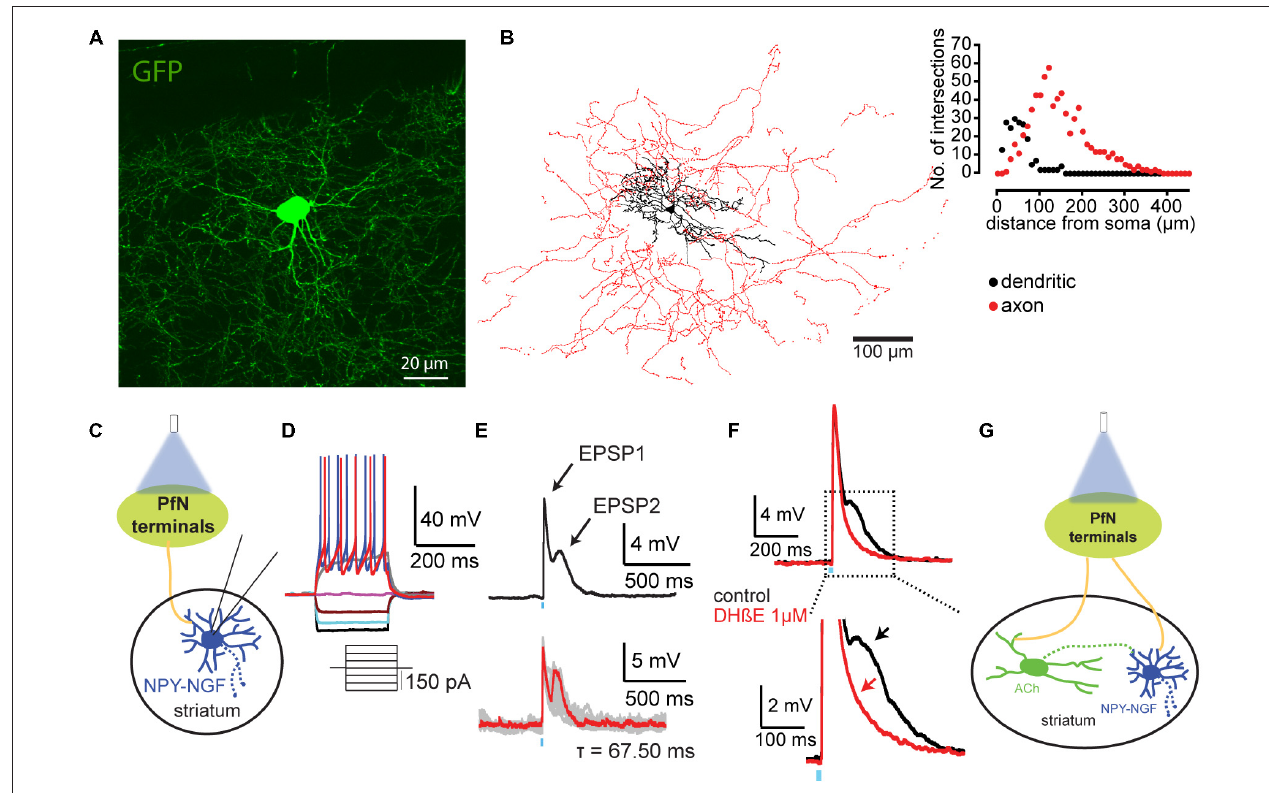
FIGURE 2 | Thalamic innervation of NGF interneurons. (A) Total projection of a confocal stack of an NGF interneuron (expressing GFP, NPY-GFP mice; B) . 3D reconstruction of an NPY-NGF interneuron filled with biocytin. The soma and dendritic fields are represented in black and the axon in red in the reconstructed image. (C) Cartoon illustrating the experimental design where we recorded striatal NGF interneurons response to PfN optogenetic stimulation. (D) Typical voltage response of a NGF interneuron to somatic current injection. (E) Optogenetic stimulation of PfN striatal terminals induces biphasic excitatory responses. (F) While